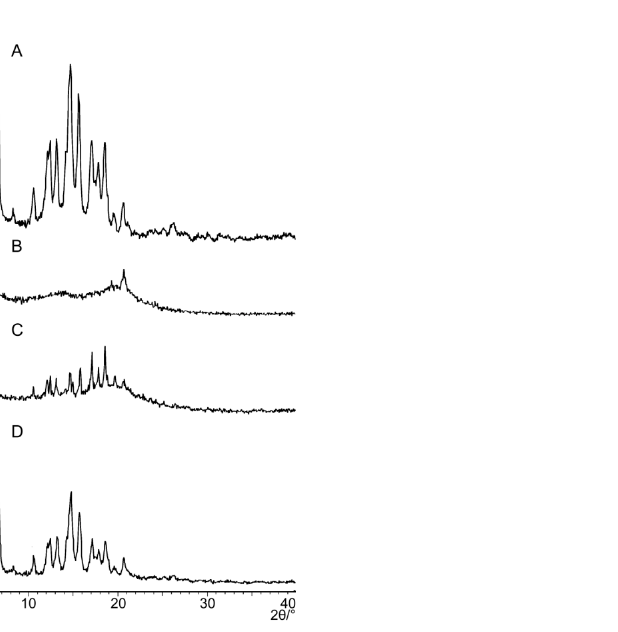
Figure 4. PXRD patterns of: ( A ) free PPD; ( B ) phospholipids; ( C ) PPD-PLC; and ( D ) physical mixture of PPD and phospholipids.